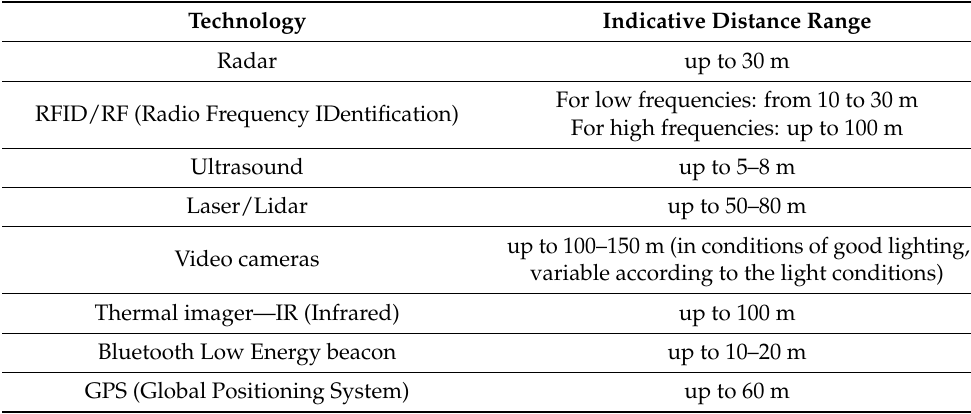
Table 4. Range of distances allowed by technology.